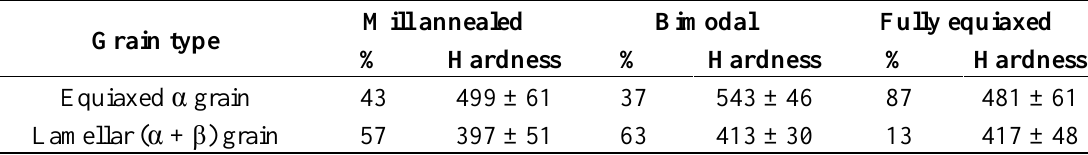
Table 2. Volume fractions and nano-hardness of equiaxed and lamellar grains for the different